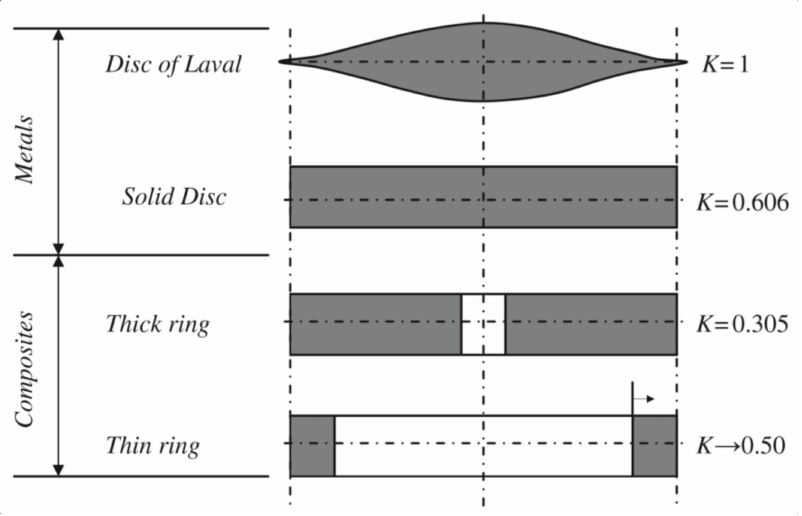
Figure 23. Shapes of FESS composed of composite and metallic materials, reproduced with permis- sion from Elsevier [141].